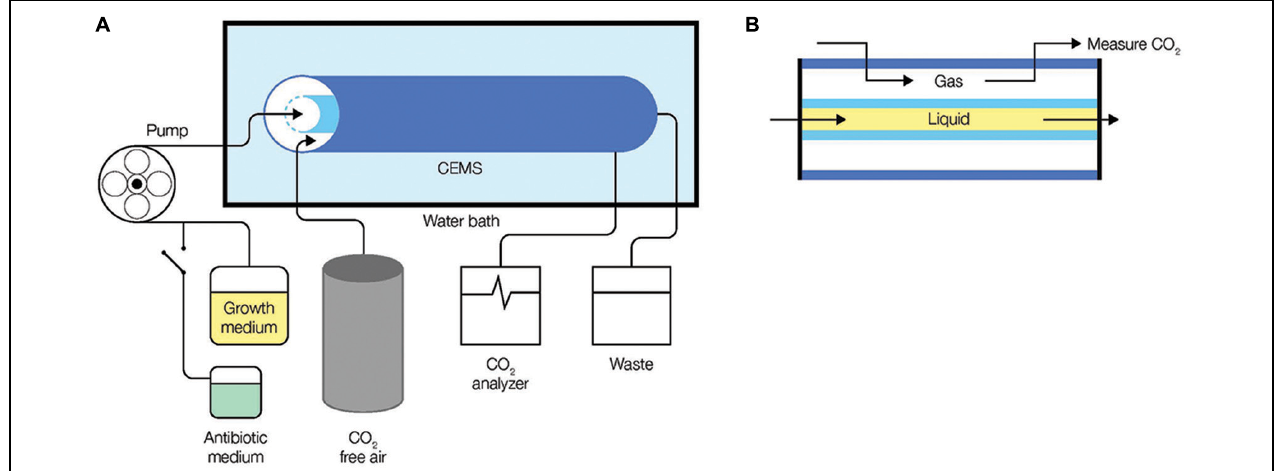
FIGURE 1 | Monitoring of biofilm metabolism through the capture of CO 2 production in real-time. (A) The CEMS system was set-up with media being fed into a gas-permeable inner silicone tube in the CEMS using a peristaltic pump. CO 2 released by biofilms in the inner tube cross the silicon wall into the annular space confined by a gas-impermeable outer tygon tube, from where it is collected and transferred by CO 2 -free sweeper gas to a CO 2 analyzer. (B) A cross-section of the CEMS showing flow of growth medium (liquid) and gas, separated by a gas-permeable silicone.